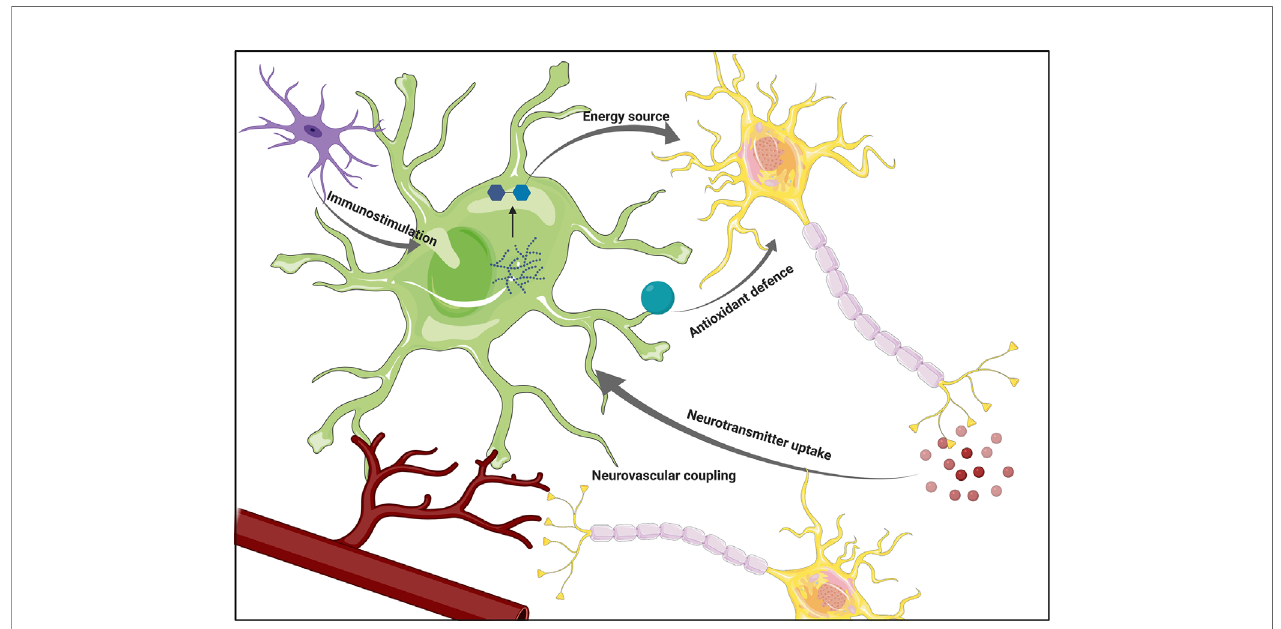
FIGURE 1 | The overview of astrocytic functions. Astrocytes support neuronal functions by providing energy substrates and supporting antioxidant defense. Their ability to participate in the immune response by sensing cytokines secreted by microglia, as well as participation in neurovascular coupling positions them as a crucial component of the interplay between various brain cell types. Figure created with BioRender.com using images adapted from Servier Medical Art by Servier, licensed under a Creative Common Attribution 3.0 Unported License